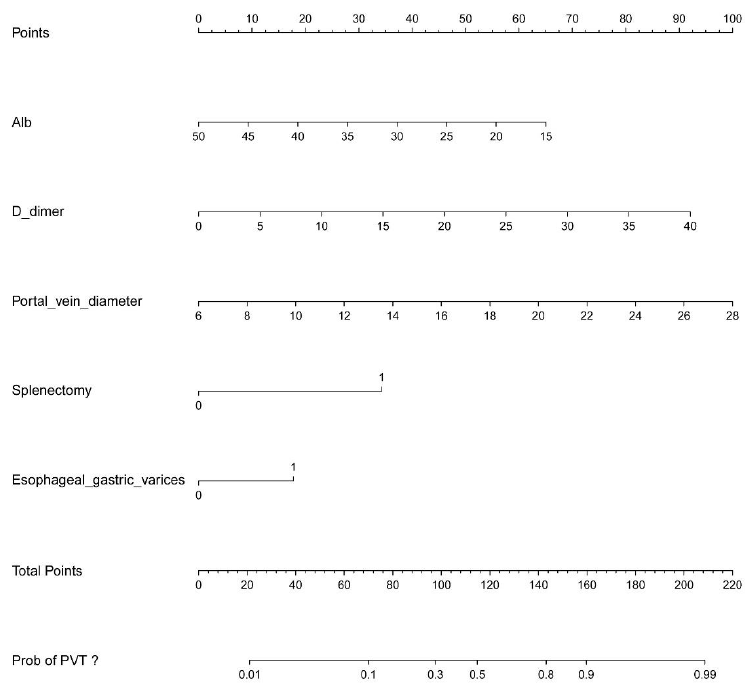
Figure 2. Nomogram of predicting PVT formation based on the independent risk factors. Each variable value has a score on the upper scale axis. The total score can be calculated by summing up each score, then projecting the total score onto the lower total scale axis, and finding the risk probability corresponding to the total score.